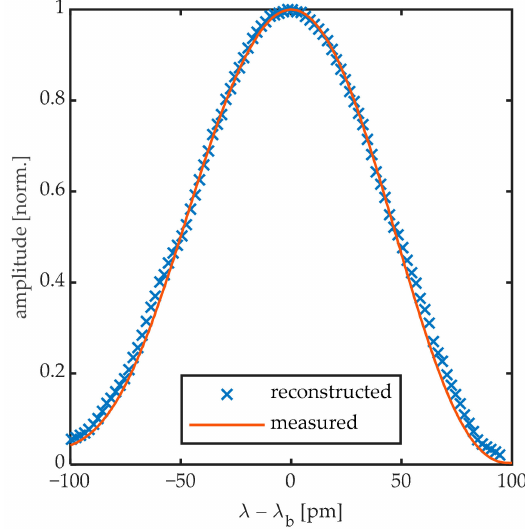
Figure 7. Initially measured reflection spectrum compared to the stepwise reconstructed spectrum at t = 0 obtained from the UGW o ff set